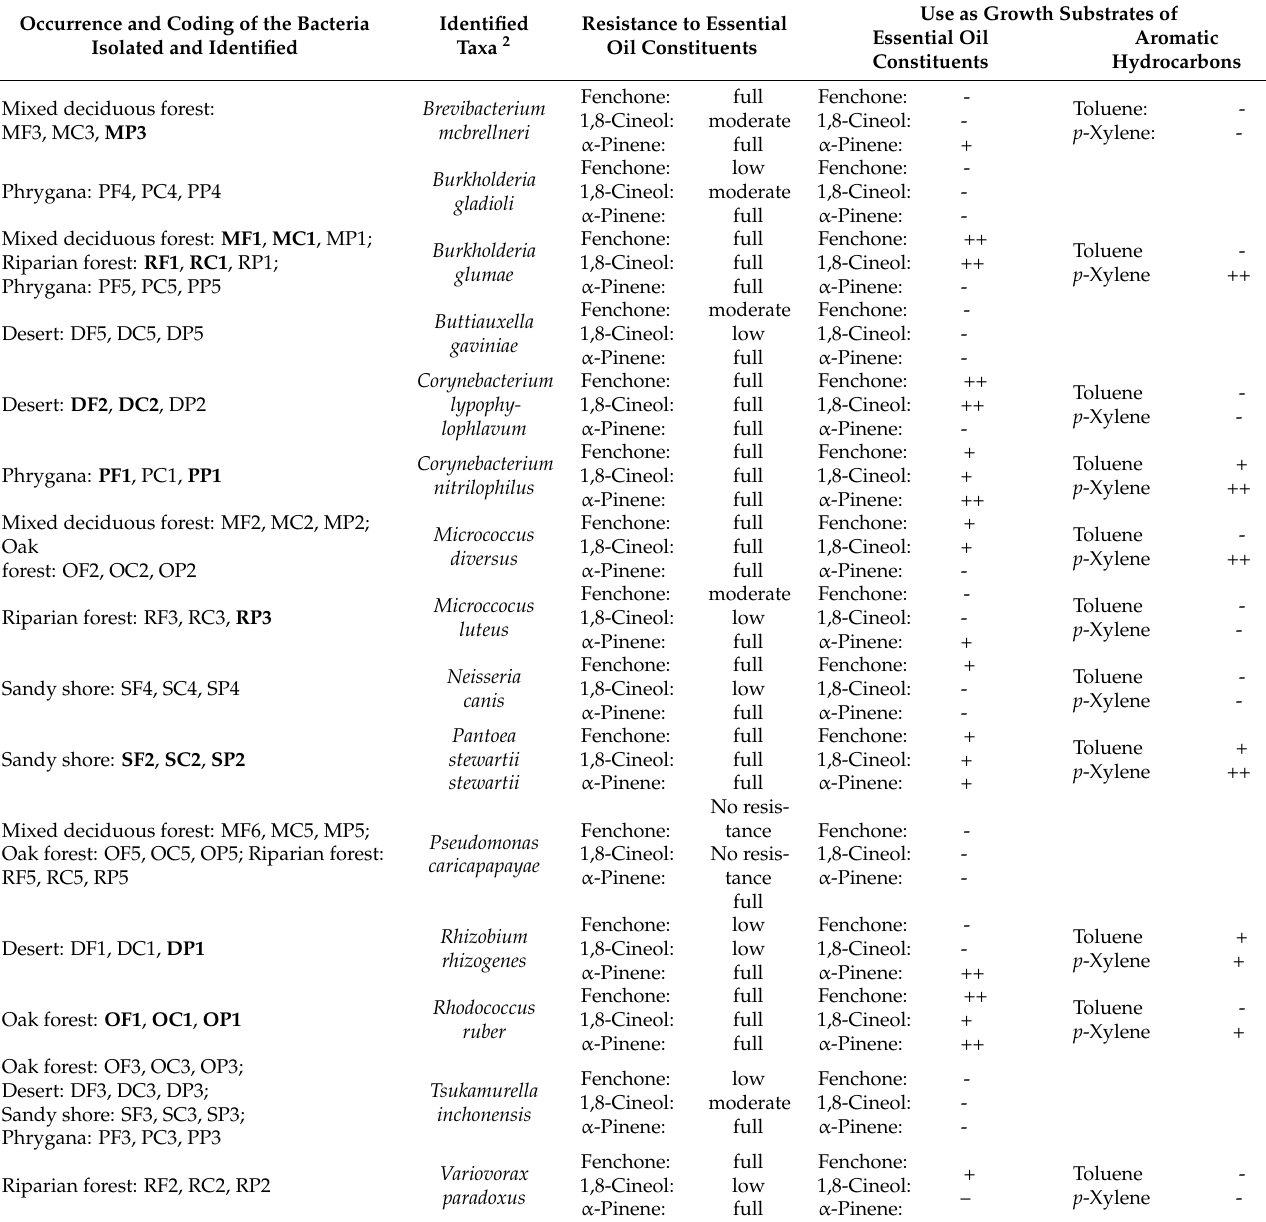
Table 2. Isolated bacterial strains and their occurrence, identification, resistance to the monoterpenes added, and ability to use fenchone (F), 1,8-cineol (C), α -pinene (P), toluene and p -xylene as substrates of growth; for the latter two compounds, this ability was tested only for bacteria that could use at least one of the three monoterpenes. Bacteria were isolated from the soils of mixed deciduous forest (M), oak forest (O), riparian forest (R), phrygana (P), sandy shore (S), and desert (D) 1 . Whenever codes are in bold, it means that the corresponding bacteria were dominant, making more than half of all colonies of the main culturable bacteria that were isolated from the soil samples of the specific treatment. The symbol (+) means that the isolated bacteria had the ability to use the compound offered, (-) that they did not, whereas (++) means that this ability was strong. For full description of the levels of the different responses, see Materials and Methods. Use as Growth Substrates of Identified Resistance to Essential Essential Oil Aromatic Taxa 2 Oil Constituents Constituents